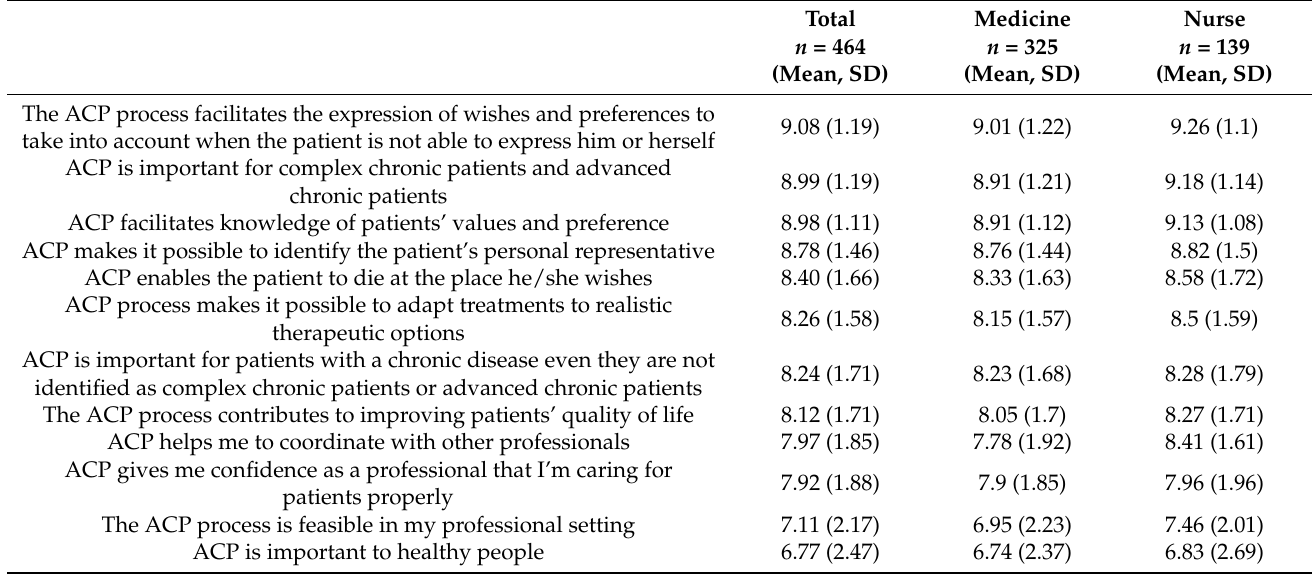
Table 3. Perception of ACP 1 practices by field.